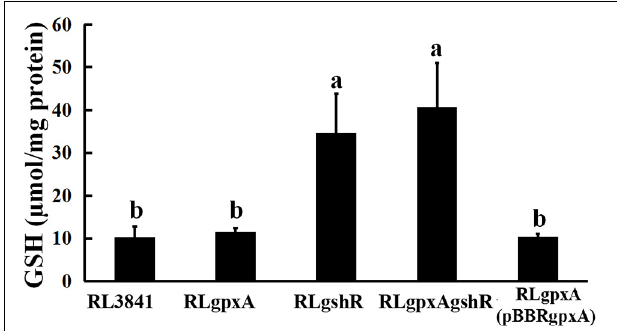
FIGURE 1 | The accumulation of reduced glutathione in R. leguminosarum strains. Data are from three biological samples ( ± SEM). a , b Different letters indicates the value is significantly different (two-way ANOVA, P < 0.05).